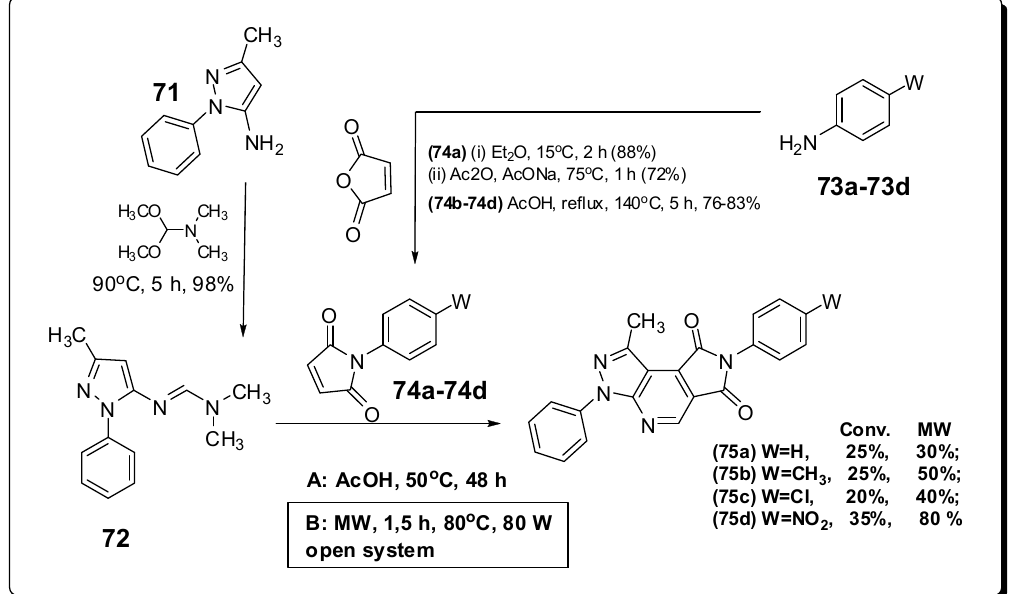
Figure 23. Synthesis of the intermediates 72 and 74a – d followed by the hetero